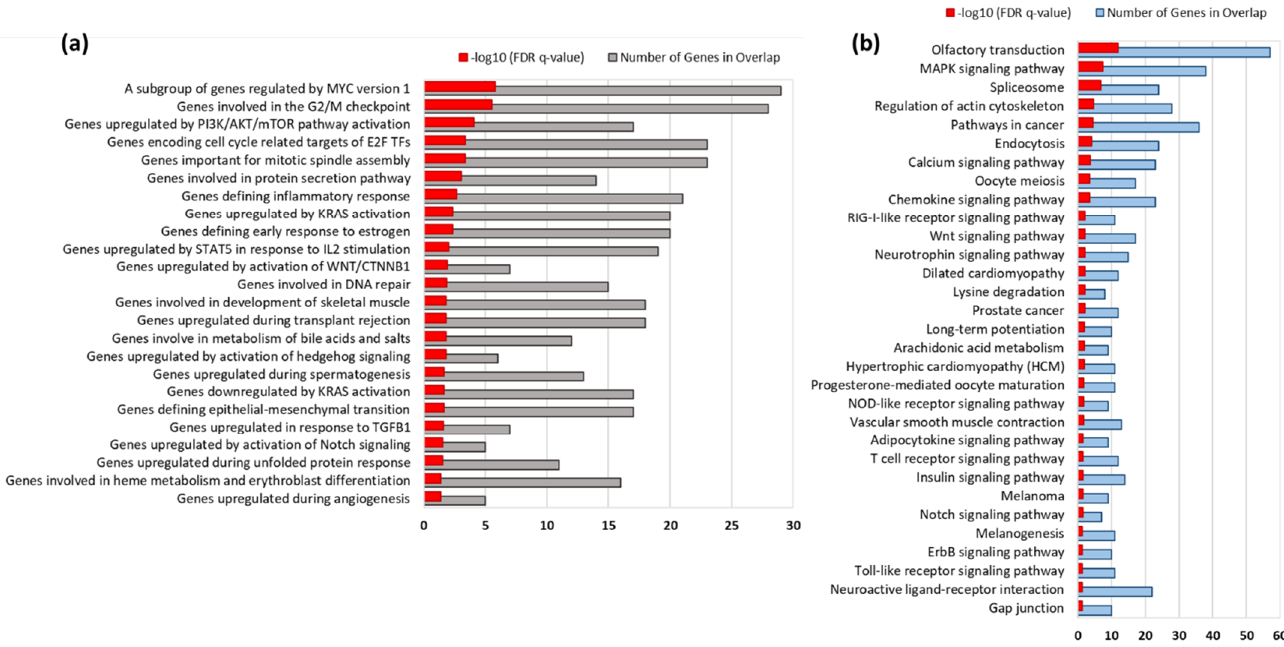
Figure 2. ( a ) Bar graph showing the top enriched Hallmark gene sets. ( b ) Bar graph showing the significant KEGG pathways. Gene set enrichment analysis was conducted using